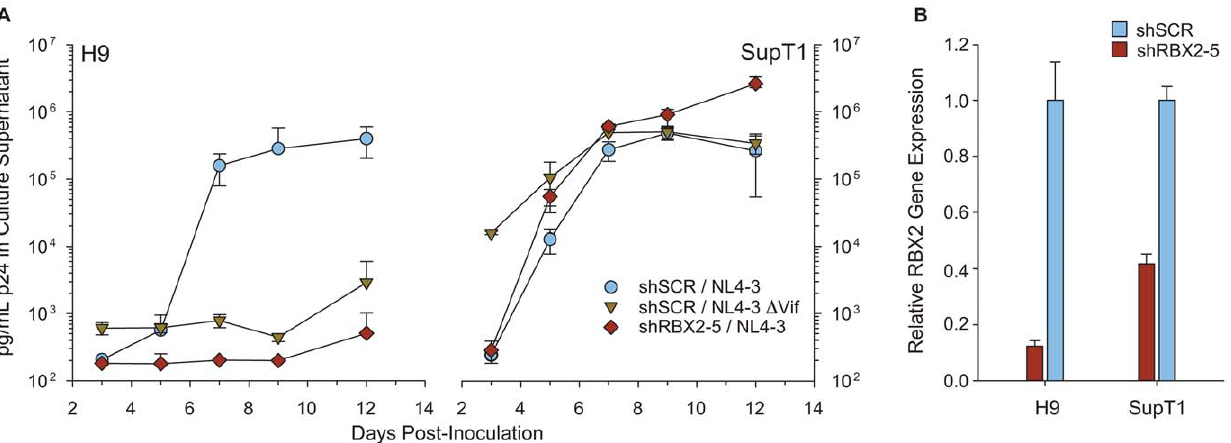
Figure 4. RBX2 is required for viral spread through non-permissive CD4 + H9 T-cells. A, HIV multiple round replication assays are shown for indicated viruses in Vif-permissive (SupT1) or Vif non-permissive (H9) cell lines transduced with viruses producing either control (shSCR) or RBX2- specific (shRBX2-5) shRNAs. Blue circles indicate shSCR treated cells infected with NL4-3 virus, yellow triangles indicate shSCR treated cells infected with NL4-3 virus lacking Vif, and red diamonds indicate shRBX2-5 treated cells infected with NL4-3 virus. Points are the mean of three independent biological replicates, error bars indicate 1 SD. B, Relative RBX2 mRNA knockdown normalized to non-silencing shSCR control as determined by RT- qPCR for the cell lines shown in panel A. Bars indicate the average of triplicate measurements, error bars are 1